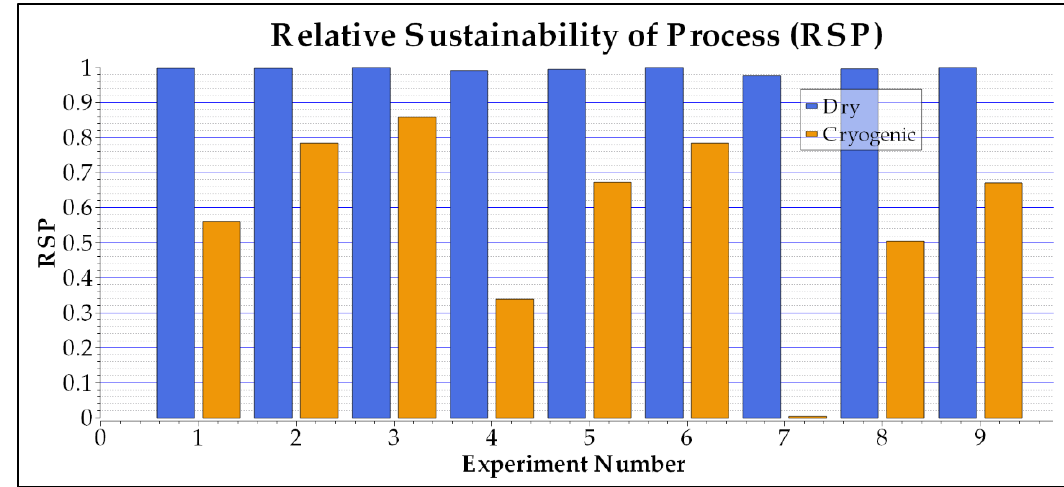
Figure 6. RSP of the alternatives in Khanna and Agarwal [26].